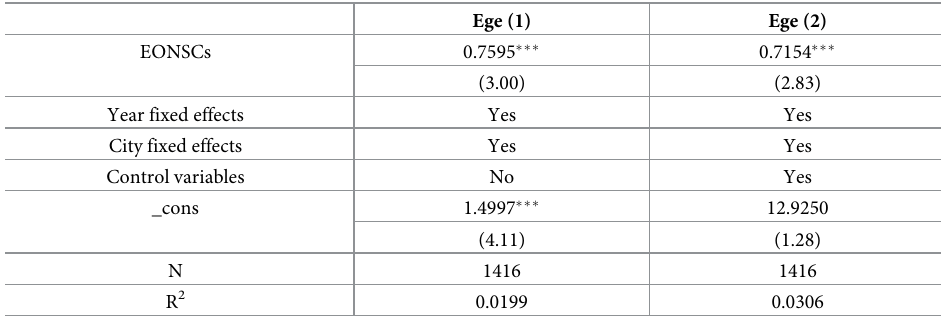
Table 6. The results of the robustness test for the PSM-DID